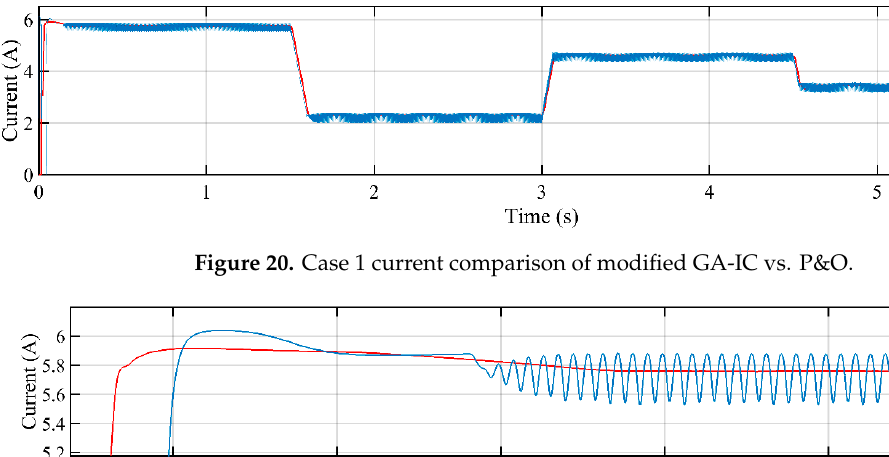
Figure 19. Case 1 voltage comparison of modified GA-IC vs. P&O.